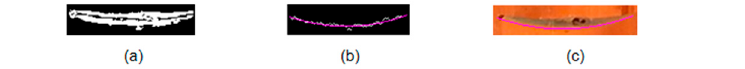
Figure 17. Reconstruction of the concave liquid level, including ( a ) Actual level line, ( b ) Liquid level extraction and reconstruction, ( c ) Reconstructed effect.